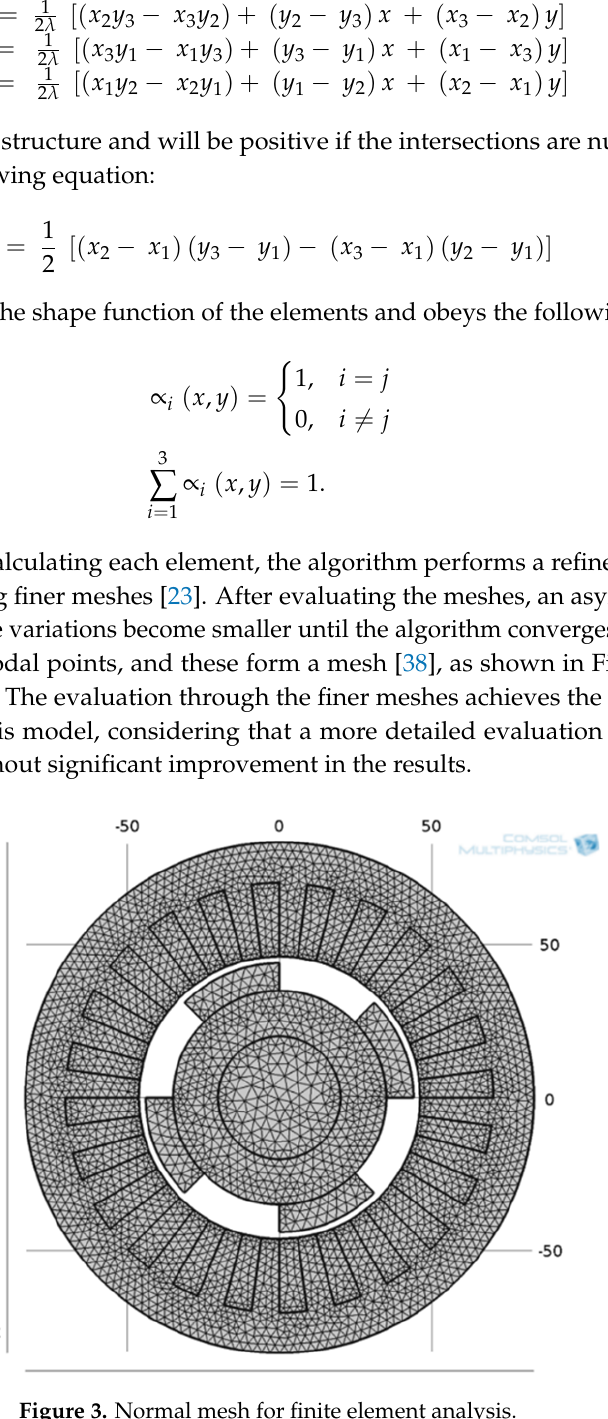
Figure 3. Normal mesh for finite element